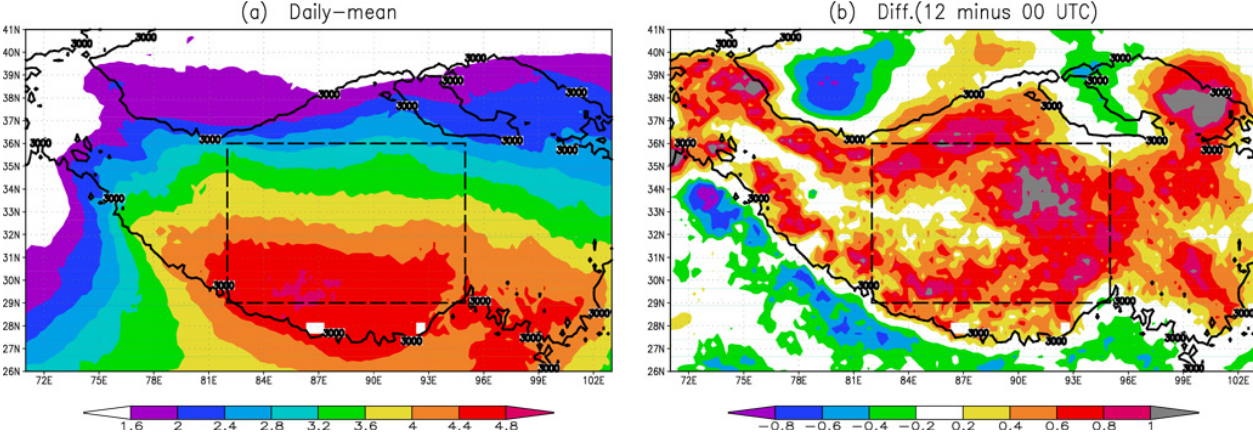
Fig. 8. 450hPa water vapour mixing ratio (gkg − 1 ) : (a) daily mean, (b) difference between 12:00 and 00:00UTC. Solid lines indicate the 3000m topography. The dashed rectangles represent the central